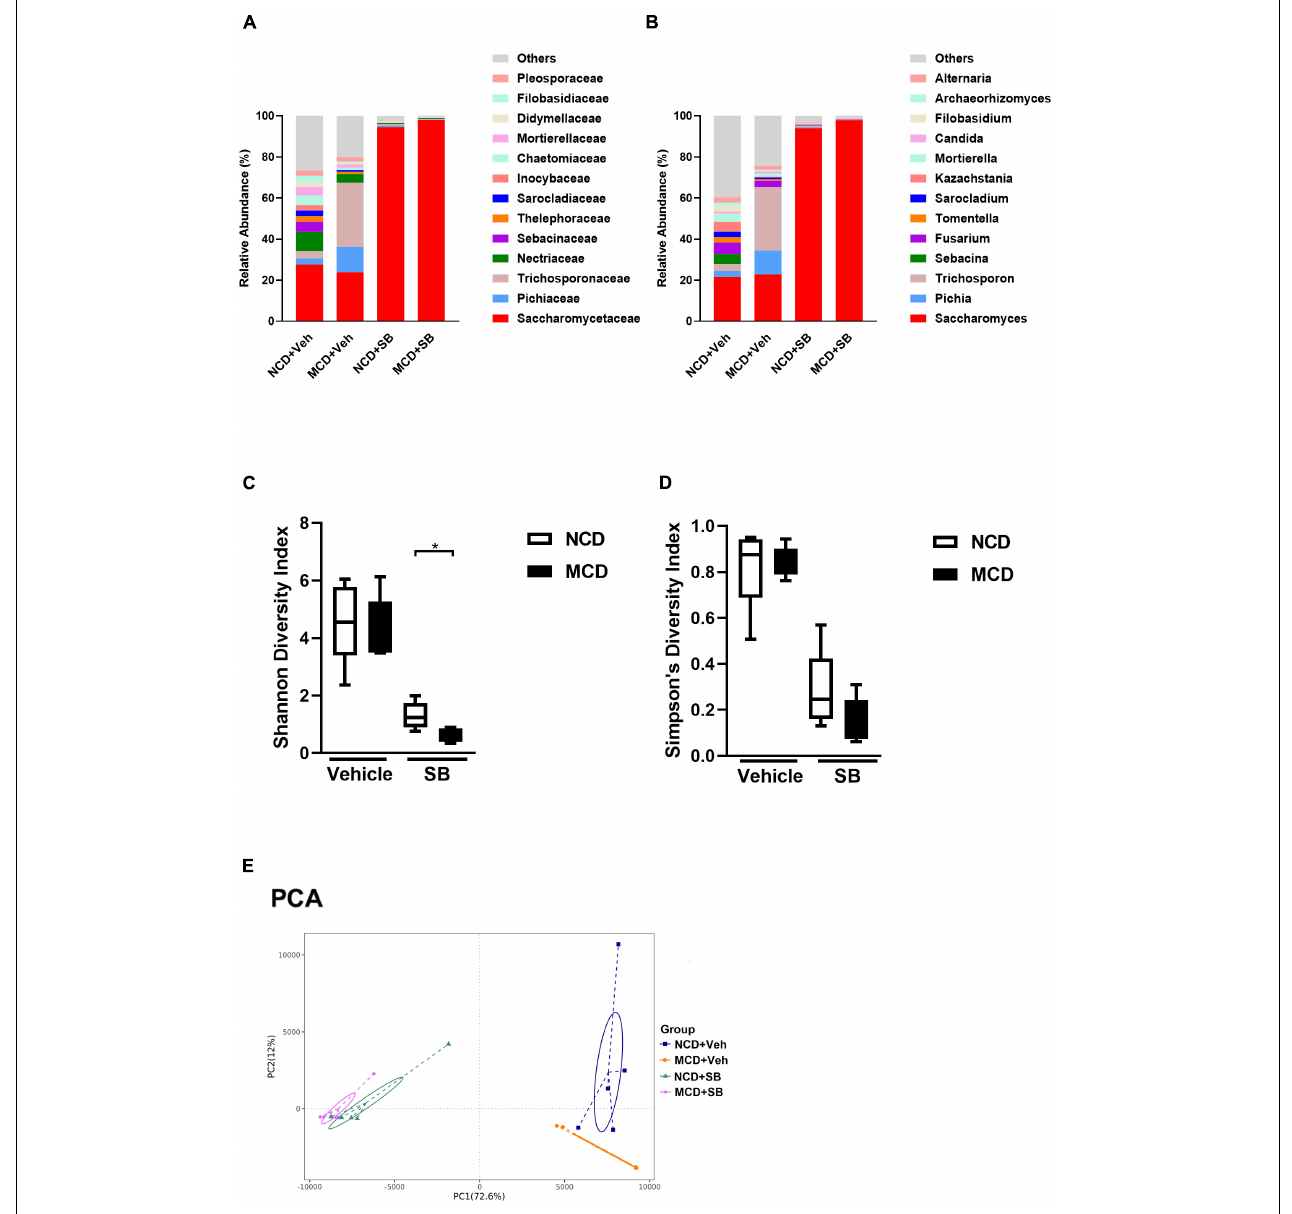
FIGURE 8 | The MCD diet altered the fungal composition in the intestine of mice. (A) Topmost abundant taxa at the family and (B) genus level, MCD diet feeding showed increased Pichia and Trichosporon . Alpha diversity is represented by Shannon (C) and Simpson’s (D) diversity index. (E) Beta diversity presented by PCA. Each symbol represents one sample ( n = 4–6 per